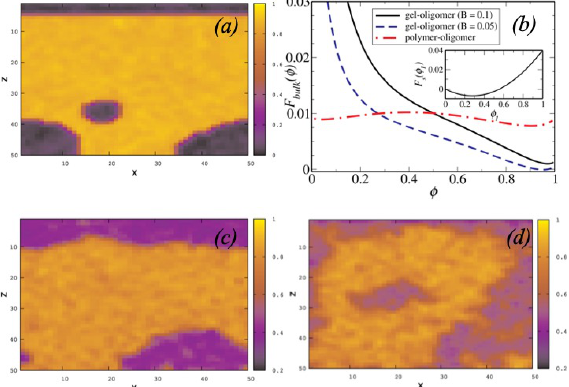
Figure 3. Oligomer concentration configurations for OP ( a ) and OG ( c , d ) systems showing polymer rich (yellow) and oligomer rich (dark) domains obtained from mesoscale simulations with oligomers wetting the wall at z = 0. ( b ) shows Flory–Huggins (red dashes) and Flory–Rehner (blue dash-dotted line B = 0.05, and black solid line B = 0.1) forms of bulk free energies corresponding to these mixtures; ( b ) shows variation of surface free energy of oligomers for interaction parameters g 0 = 0.18 and h 0 = − 0.05 as a function of the surface oligomer concentration φ 1